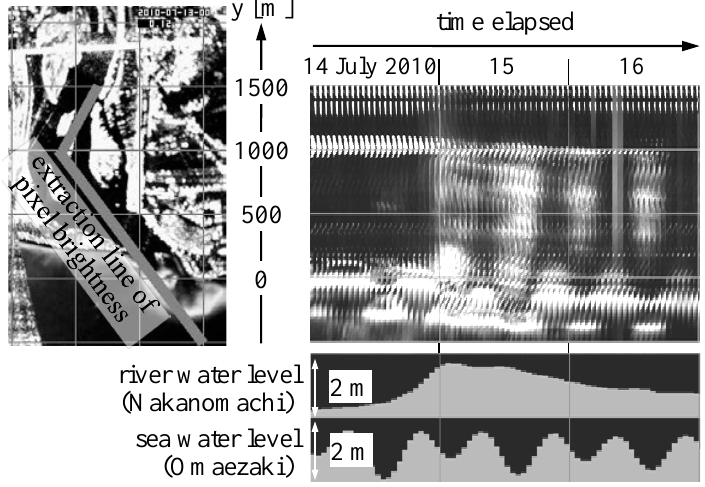
Figure 5. Migration of streaky light-dark patterns downstream in the river channel: Time-averaged radar image (left) and time stack image (right). y denotes north-south coordinate shown in Figure 1b. In the time stack, oblique propagations towards the lower right can be seen, which indicate